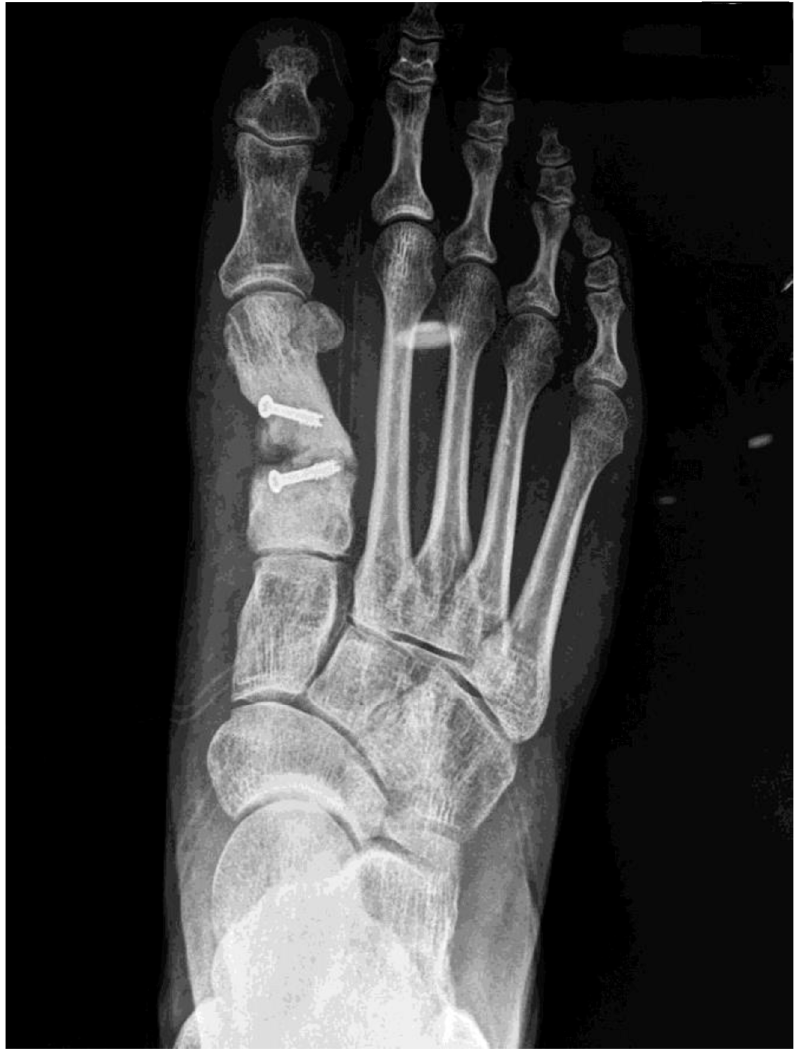
Figure 2. Rx AP immediately preoperative.